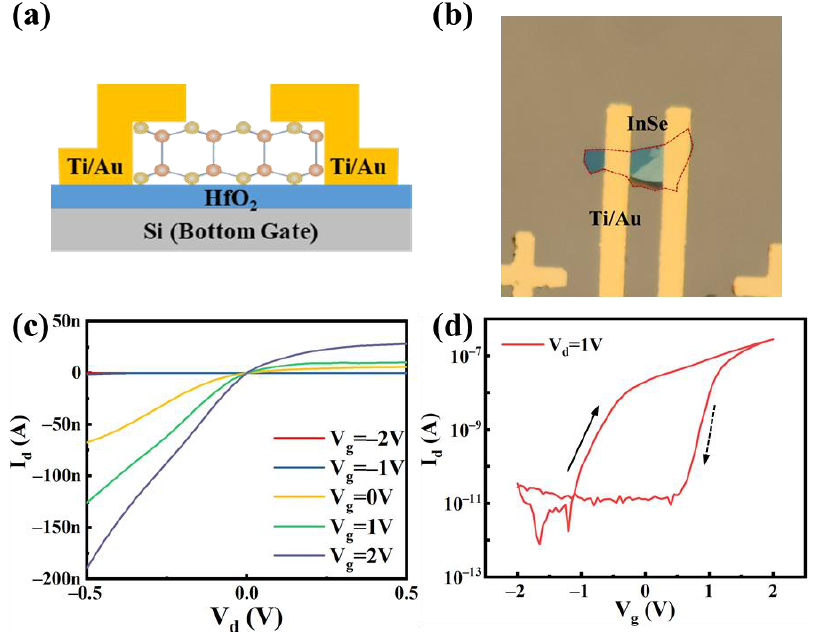
Figure 2. ( a ) Schematic diagram of bottom-gated InSe FET. ( b ) Optical microscope image of a typical InSe FET. ( c , d ) Transfer and output transport characteristic curves of InSe FET. Output curves are obtained at V g = − 2 V to V g = 2 V, with a step of 1 V, and transfer curves are measured at V d = 1 V. The solid and dash arrows represent Vg scans from − 2 V to 2 V and from 2 V to − 2 V.